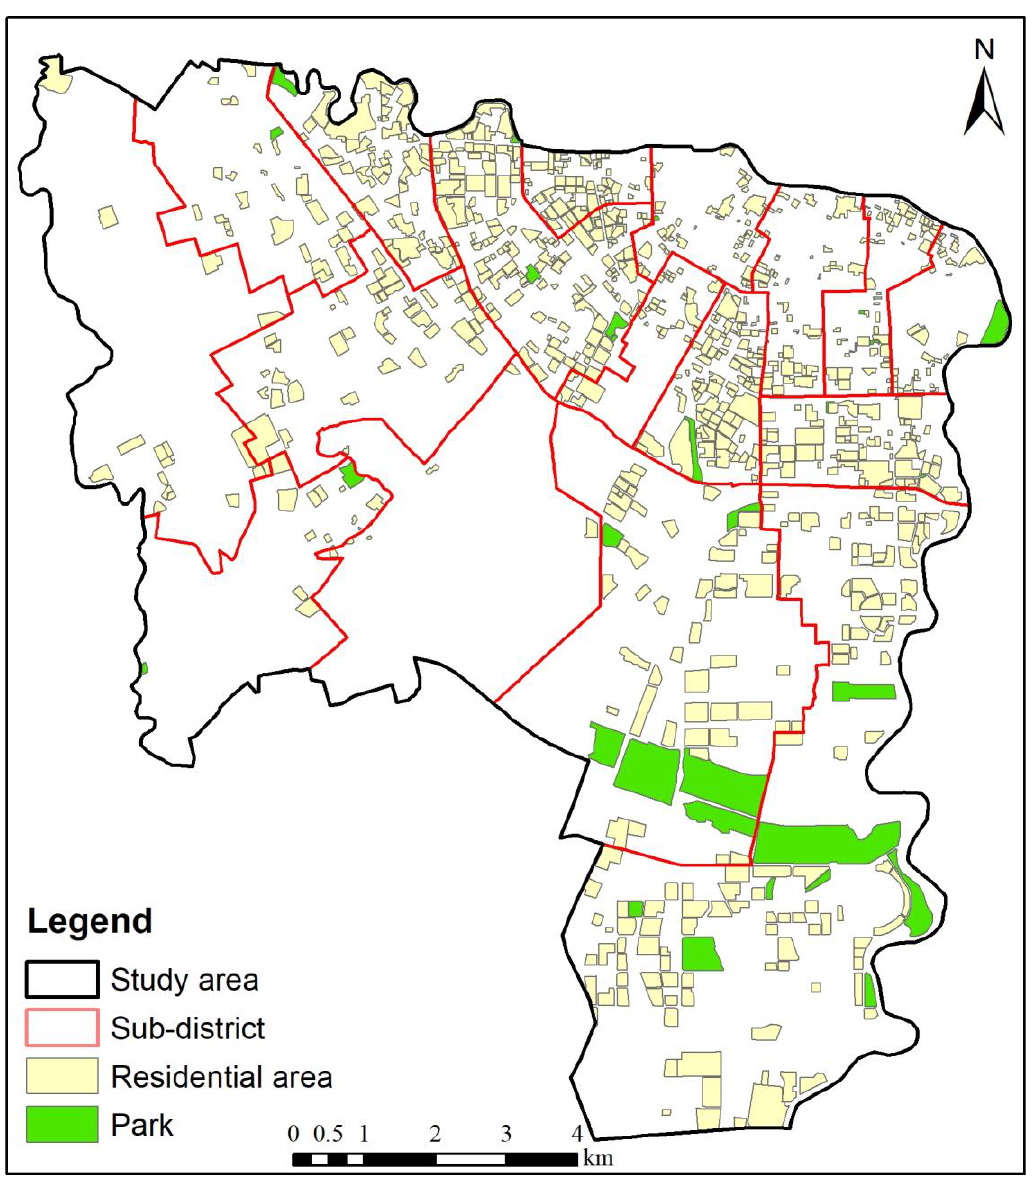
Figure 2. Data sources.